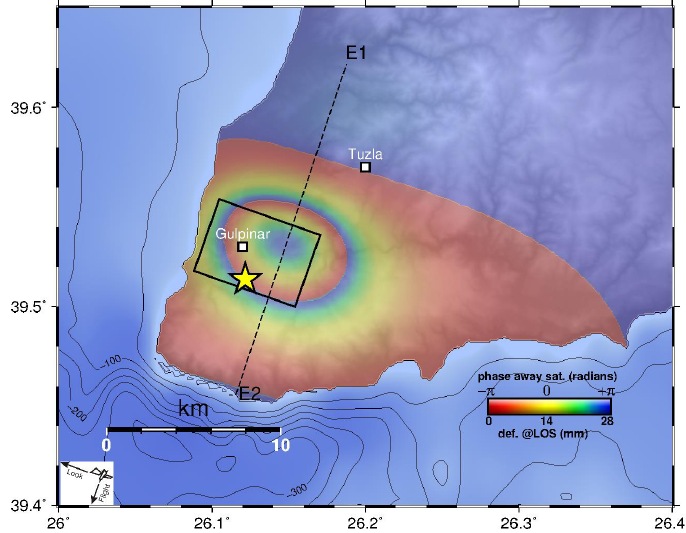
Figure 9. Map showing the Gulpinar forward model of LOS motion for the descending orbit 36 (with local incidence angle of 44°; see also Figure 10d), the surface projection of the modeled south-dipping fault (thin black box) and location of the cross-section E1 – E2 (dashed black line; plot as Figure 11). Background monochromatic image is ASTER topography. Yellow star indicates the relocated epicenter in this study) of the event EQ1 (6 February 2017; M w = 5.2; 03:51 UTC).